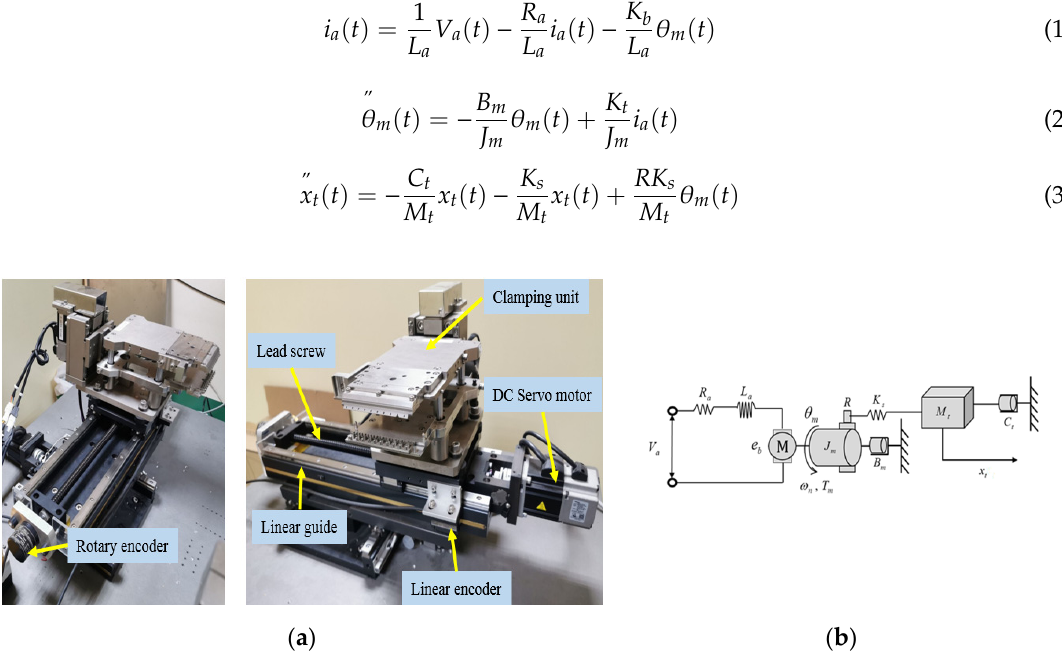
Figure 6. ( a ) Mockup unit of linear stage and motor; ( b ) physical modelling of the linear stage servo motor.